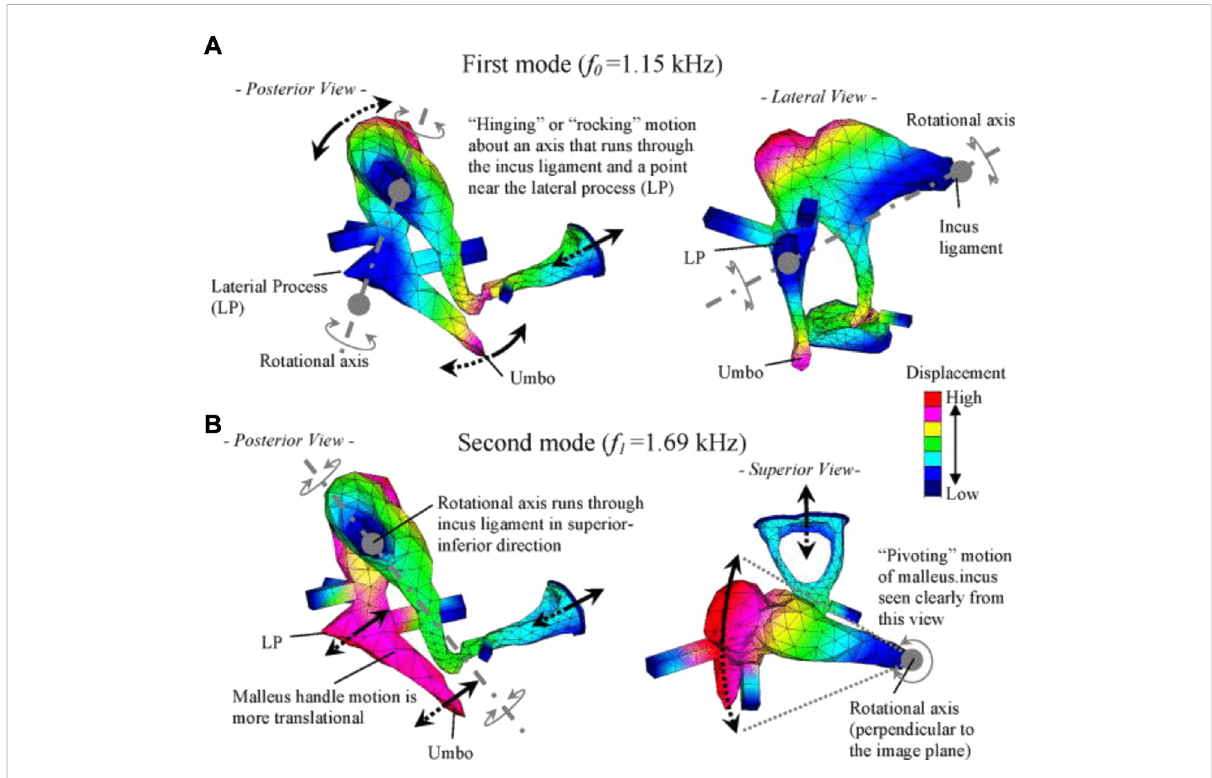
FIGURE 11 Characteristic ossicular motions described by Homma et al. (2009), reprinted with permission: (A) the fi rst mode under air conduction, and (B) the second mode under bone